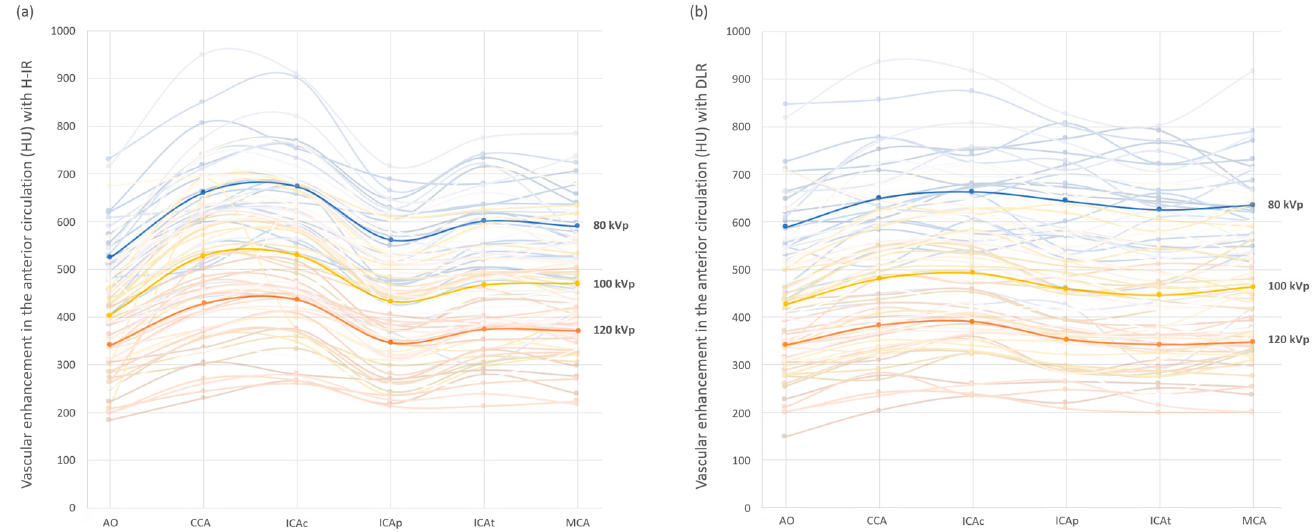
Figure 2. Arterial vascular attenuation profile for the anterior cerebral vascularization with H-IR ( a ) and DLR ( b ), with 80 kVp in blue, 100 kVp in yellow and 120 kVp in orange. Mean values are dis- played in bold lines. Vessel contrast for each patient are in the corresponding light colors. AO: Aortic arch; CCA: common carotid artery; ICAc: cervical internal carotid artery; ICAp: intrapetrous inter- nal carotid artery; ICAt: terminal internal carotid artery; MCA: middle cerebral artery.